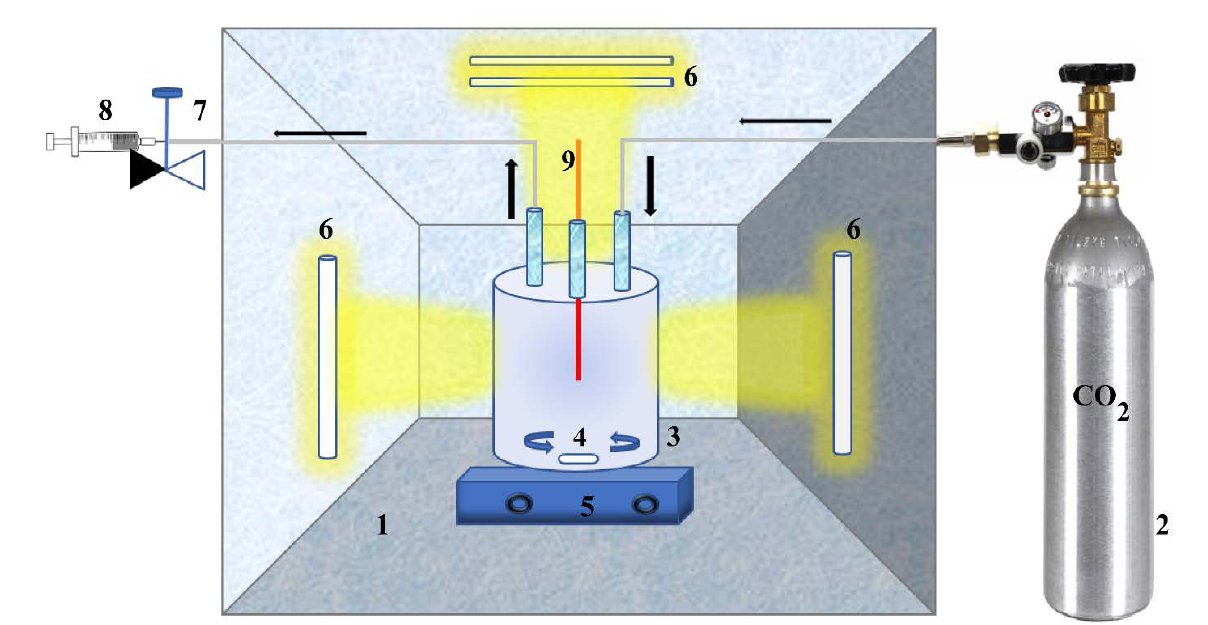
Figure 1: Schematic diagram of photocatalytic reduction experiment. Table 1: Major parameters along the sampling Figure 1. Schematic diagram of photocatalytic reduction experiment (1= vacuum chamber, 2=CO cylinder, 3= Batch reactor, 4= magnet spinner, 5= magnetic stirrer, 6=UV light, 7= gas 2 valve, 8= sampling syringe, 9= probe sensor).